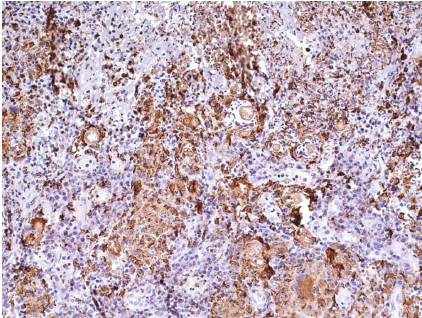
Figure 6: Immunohistochemistry showing granulomatous